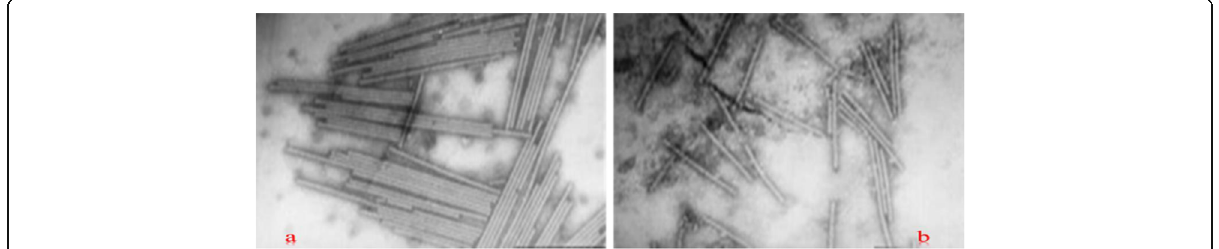
Fig. 4 Analysis of transmission electron microscope by the activity of AgNPs on morphology of TMV, a controlled and b treated with AgNPs. In the control, morphology of TMV is smooth and normal, while in the treated sample, the morphology of viroid is